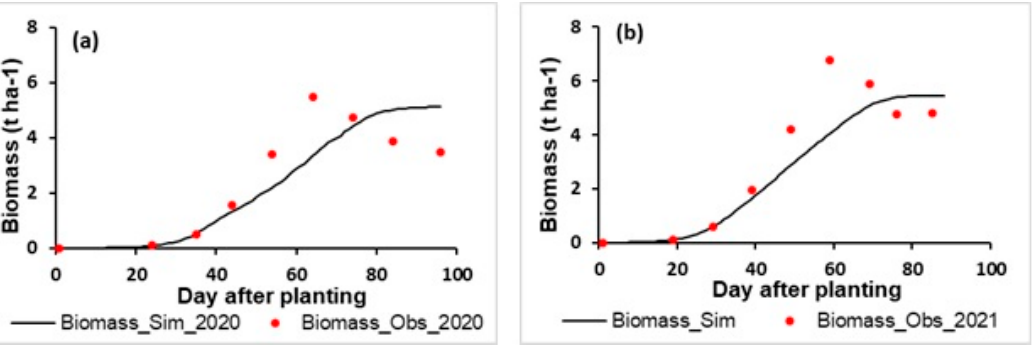
Figure 2. Total simulated and observed biomass for Summer–Autumn season 2020 ( a ) and Spring– Winter season 2021 ( b ).